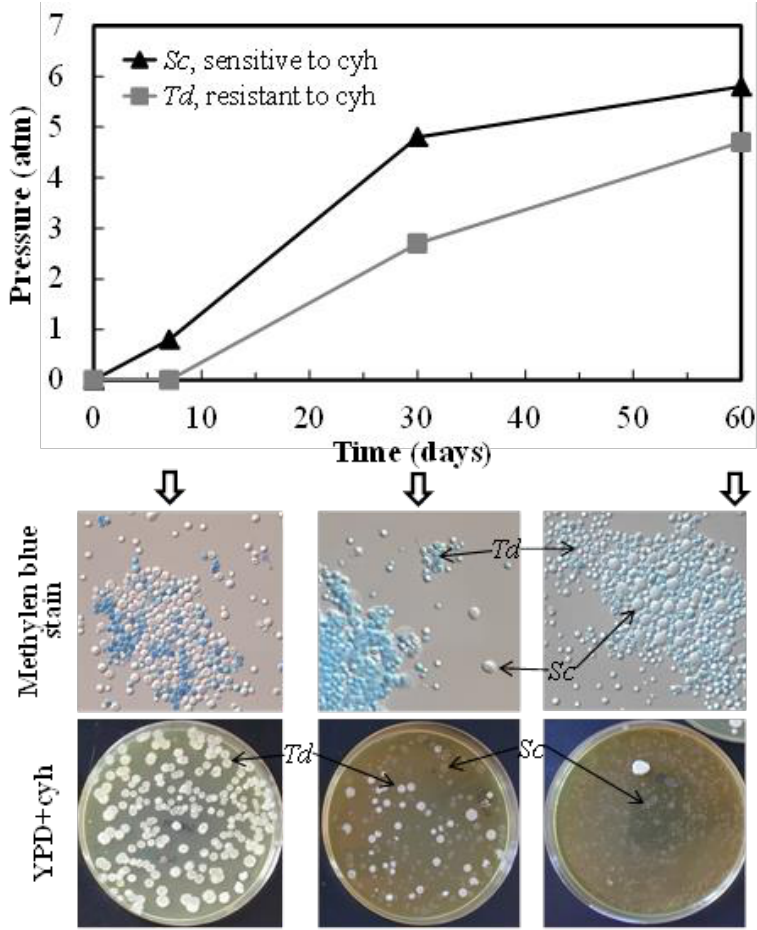
Figure 3. ( Top ) Evolution of CO 2 pressure during the second fermentation of cava wine inoculated with S. cerevisiae ( Sc ) sensitive to cycloheximide (cyh) and T. delbrueckii ( Td ) resistant to cyh. ( Bottom ) Methylene blue stain to show cell death, and cyh-resistance of viable cells (YEPD+cyh) to monitor the inoculated yeast, for the T. delbrueckii inoculated fermentation (7 days, 30 days, and 60 days of fermentation).